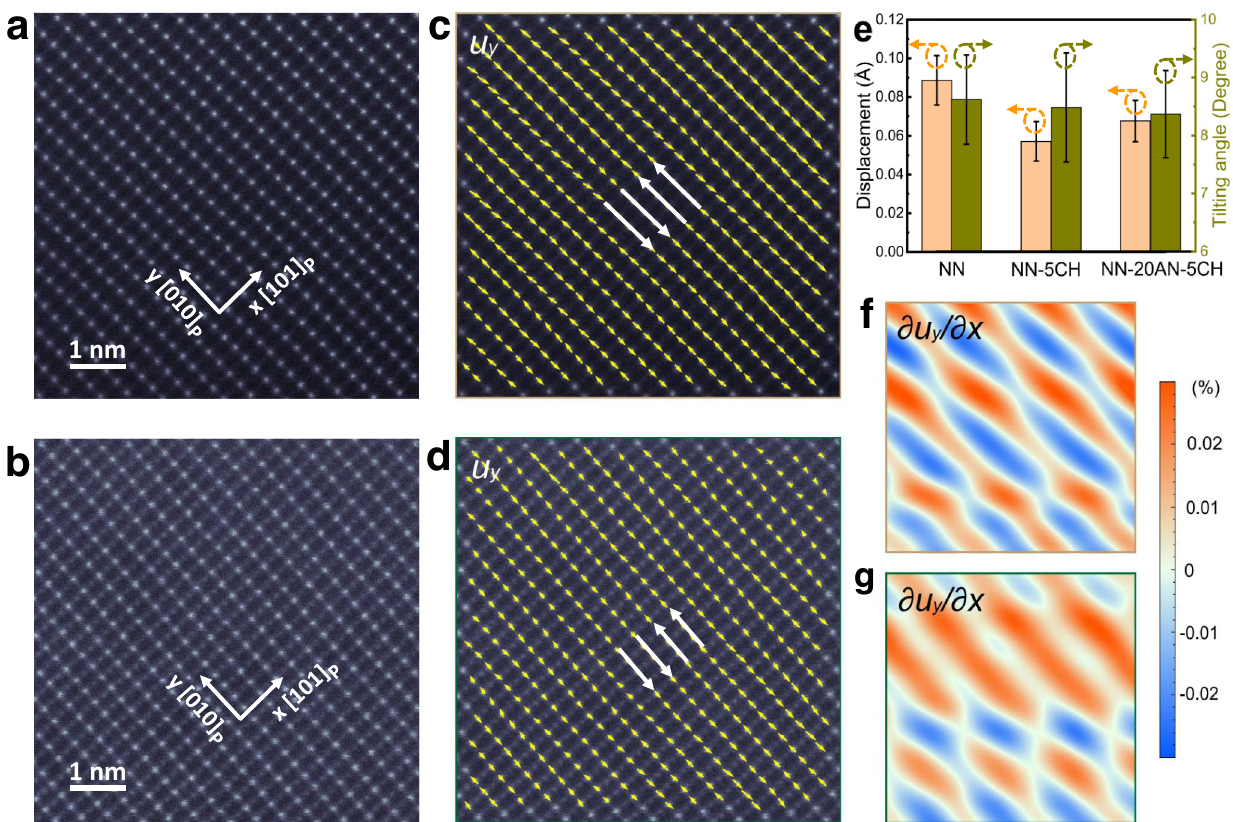
Fig. 5 | Polarization fi eld mapping. ADF images for ( a ) NN and ( b ) NN-20AN-5CH. B-site displacement map for ( c ) NN and ( d ) NN-20AN-5CH. The long white lines in ( c ) and ( d ) with antiparallel vectors are guiding line for revealing B-site displace- ments. e Displacementaveragedfrom( c )and( d ),oxygenoctahedraltiltingangle Θ